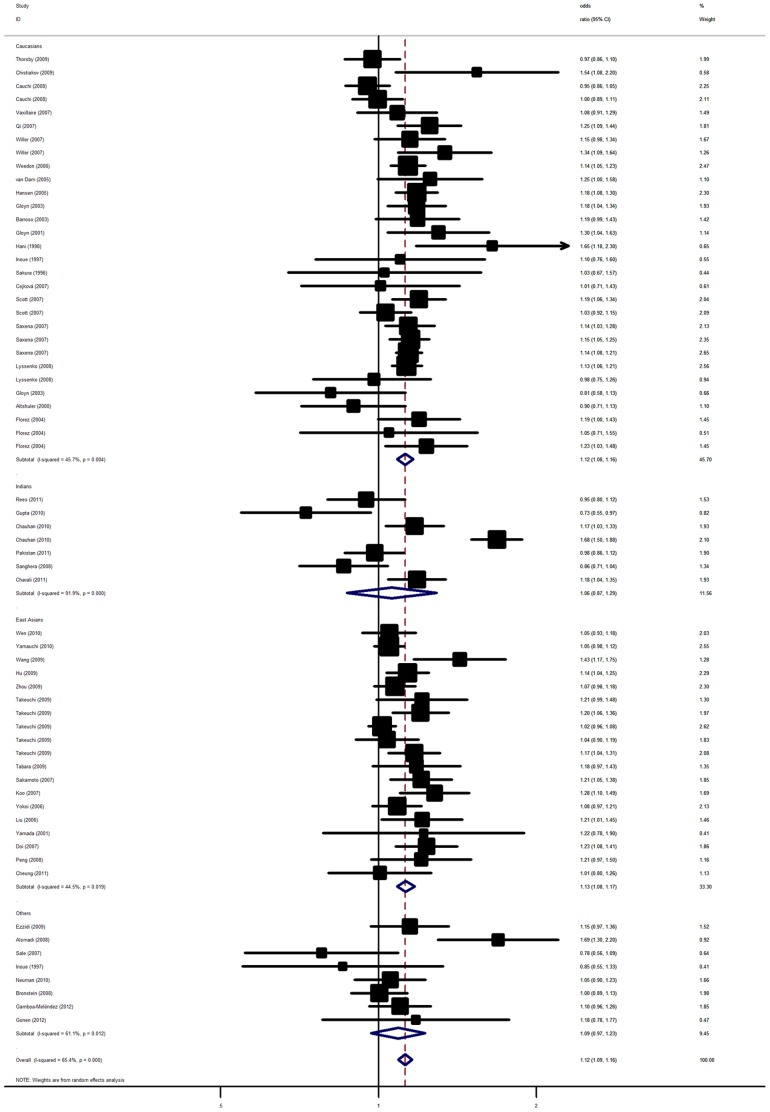
Forest plot from the meta-analysis of T2D risk and KCNJ11 rs5219 polymorphism using random-effects model.